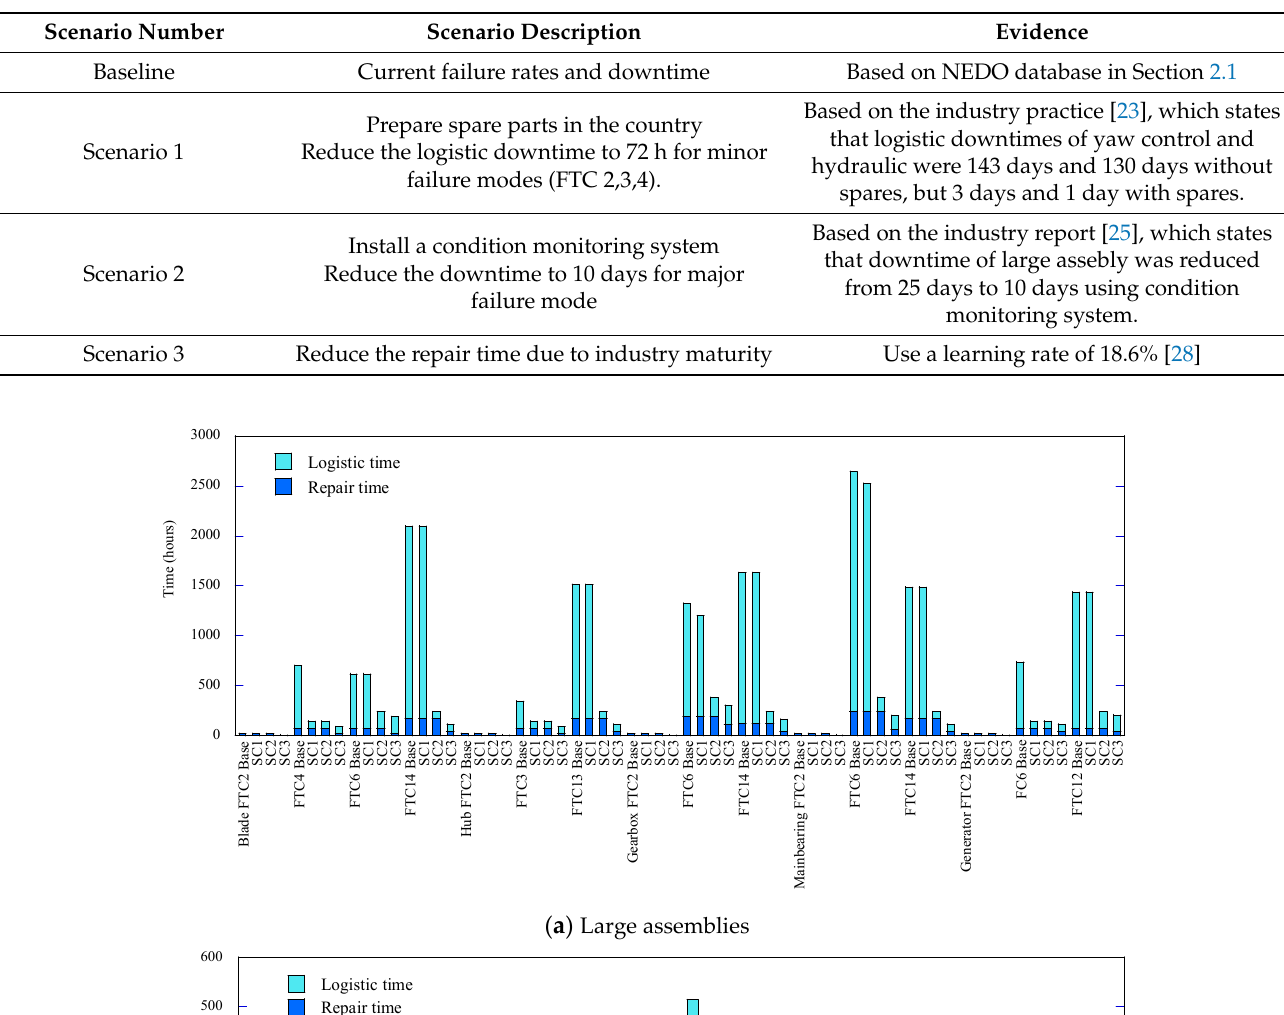
Table 5. Description of cost reduction scenarios in Japan.